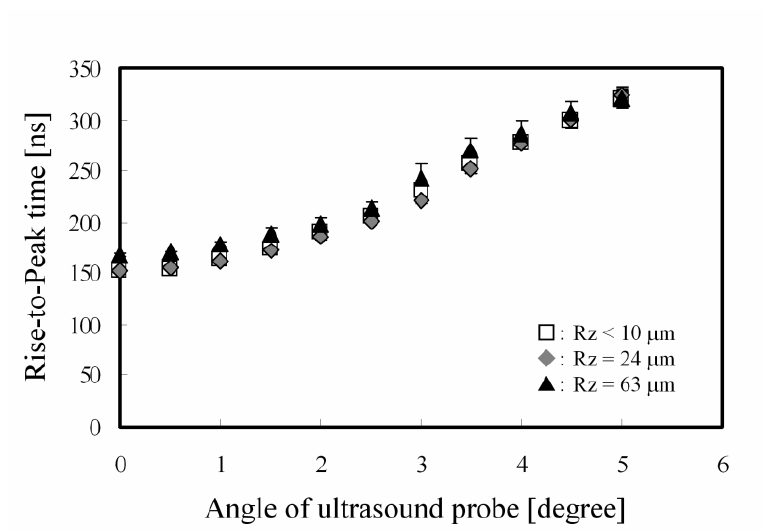
Figure 5: Relationship between Rise-to-Peak time and probe angle for the acrylic plates (Rz < 10 µ m, Rz =